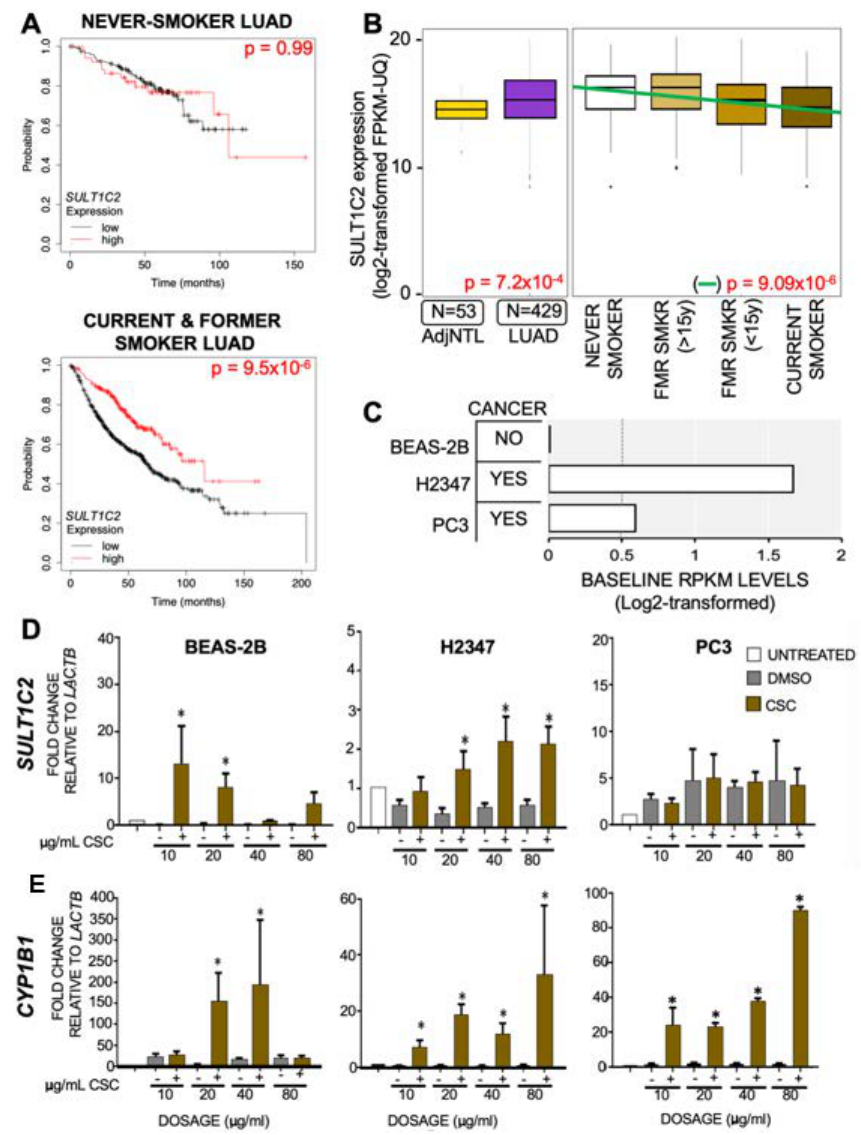
Figure 1. Expression of SULT1C2 affects overall LUAD patient survival and is activated by cigarette smoke. ( A ) Survival plots of LUAD patients stratified by SULT1C2 expression. Upper panel includes patients that never smoked; lower panel includes only patients with documented smoke exposure. KMplot [47] was used to stratify samples by upper quartile. ( B ) Left: distribution of SULT1C2 in human LUAD patient tumors and adjacent non-tumor lung from TCGA. Samples are not paired. p = 7.2 × 10 − 4 . Right: TCGA LUAD tumors split by smoking history. FPKM-UQ = Fragments per kilobase of gene per millions mapped, upper quartile normalized. ( C ) Expression of SULT1C2 in three lung cell lines. RPKM = reads per kilobase of gene per millions mapped. ( D , E ) LUAD cell lines were treated with dimethylsulfoxide (DMSO) vehicle control or cigarette smoke condensate (CSC) at 10, 20, 40, and 80 µ g/mL. Cells were treated for 24 h, and mRNA expression levels were mea- sured. White = Untreated, gray = DMSO, brown = CSC treatment at indicated doses. ( D ) SULT1C2 levels in BEAS-2B cells, H2347, and PC3_LUAD cells. ( E ) CYP1B1 levels in BEAS-2B, H2347, and PC3_LUAD cells. n = 3. All qRT-PCR data are normalized to LACTB levels in matched cell line. n = 3. (*) = p ≤